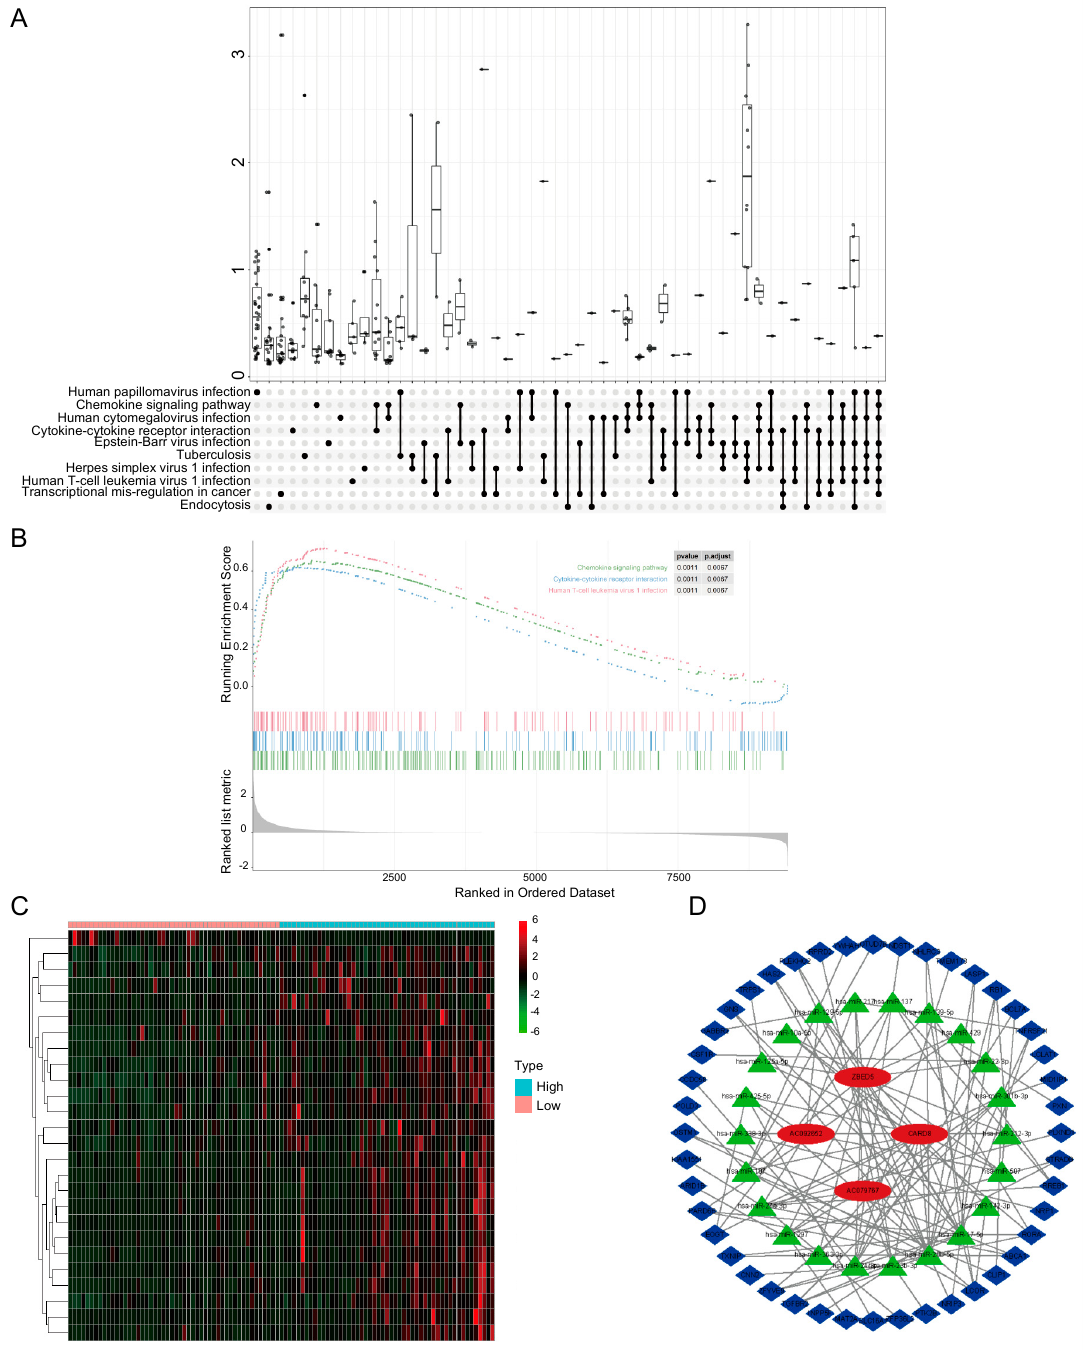
Figure 2. GSEA and ceRNA network construction. ( A , B ) The ssGSEA package was used for GO and KEGG enrichment analyses of all DEGs. The KEGG enrichment results are presented in the form of an upset plot ( A ). The top three terms in the GSEA were chemokine signaling, cytokine − cytokine receptor interaction, and Human T − cell leukemia virus 1 infection. ( C ) Differentially expressed lncRNA heat map for the validation set. ( D ) Based on the differentially expressed lncRNAs and mRNAs, a ceRNA network was constructed: green represents mRNAs, blue represents miRNAs, and red represents lncRNAs.